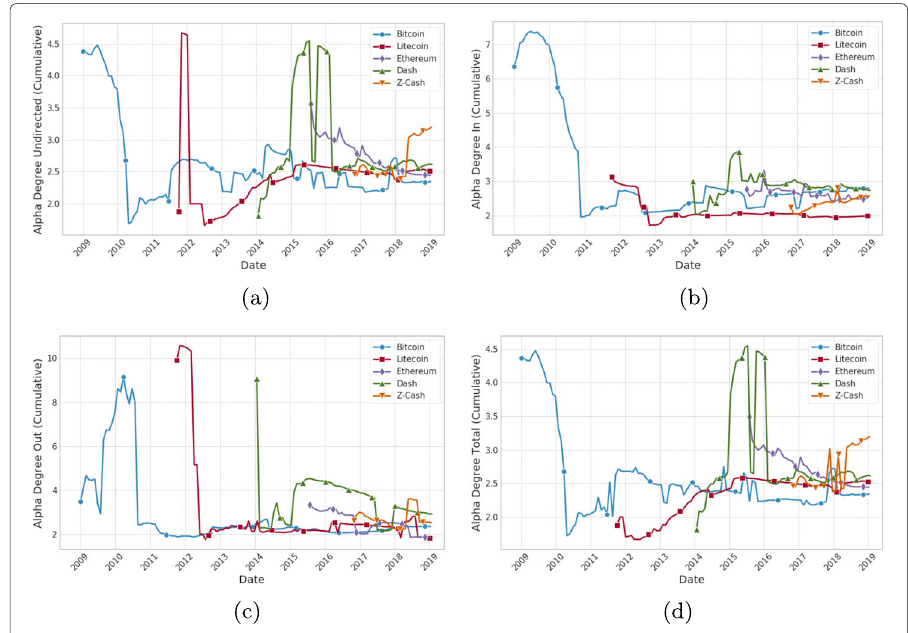
Fig. 12 Alpha parameter of the Power-Law distribution over the degrees sequence of the CMTG. a Degree of undirected graph. b In-degree of directed graph. c Out-degree of directed graph. d Total-degree of directed